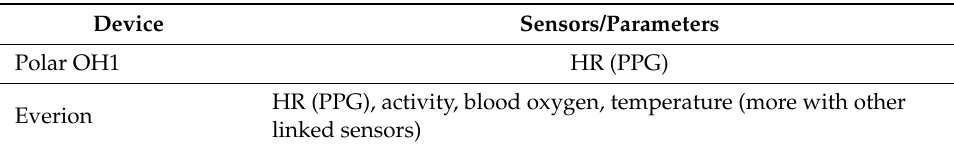
Table 4. Examples of wearable consumer grade upper arm cardiac